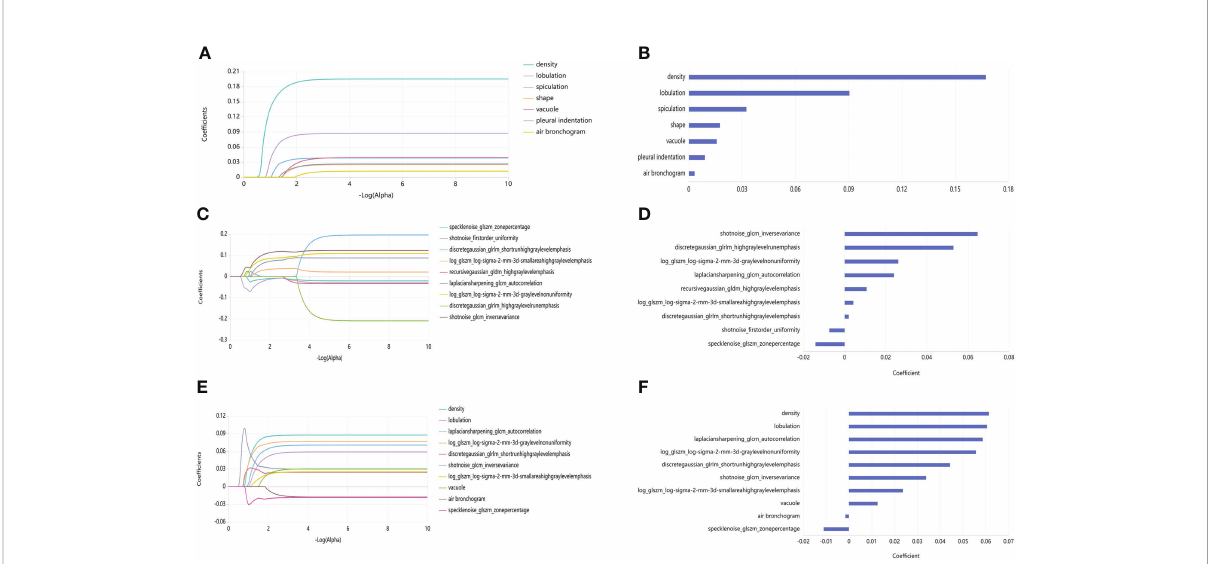
FIGURE 3 LASSO maps and feature weighted graphs for the three models. (A) LASSO map of Radiological model. (B) Weighted graph of Radiological model features. (C) LASSO map of Radiomics model. (D) Weighted graph of Radiomics model features. (E) LASSO map of R-R model. (F) Weighted graph of R-R model